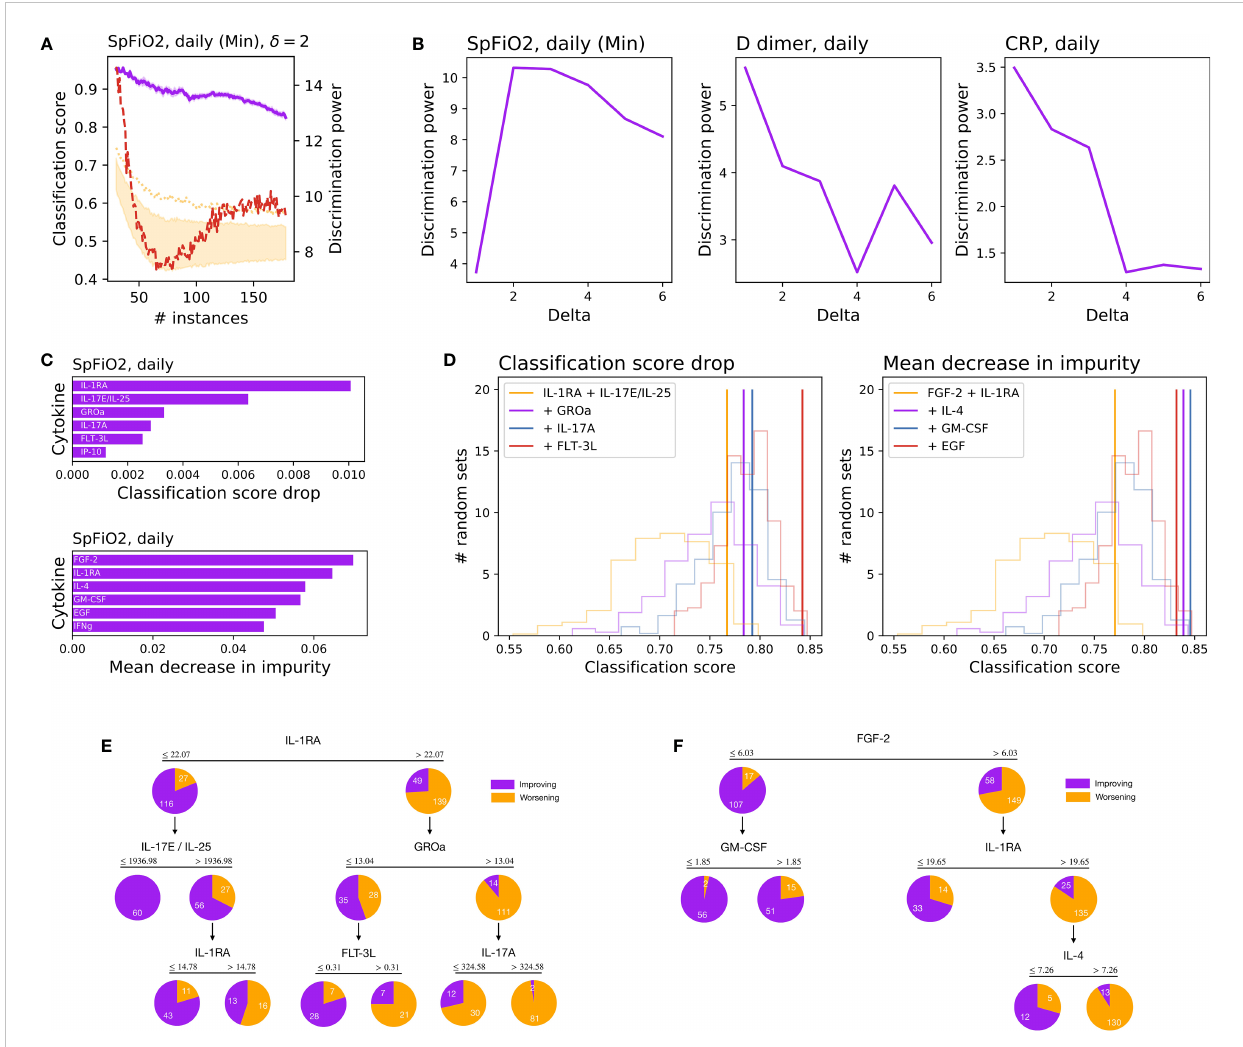
FIGURE 4 Results of the machine learning analysis and models. (A) Classi fi cation score (purple line, left Y axis) between two equal-sized groups of most improving and most deteriorating patients, as a function of the number of patients in each group, for a delay of d =2 days. The orange band and dotted line respectively represent the 10-90 percentile and 99 percentiles of a random classi fi cation. The red line (right Y axis) depicts the variations of the discrimination power. (B) Variations of the discrimination power, as a function of the number of days, for the three metrics used to assess the status of the patient. (C) Ranking of the fi ve most important cytokines for forecasting the status of patients two days ahead, according to the classi fi cation score drop (top) and mean decrease in impurity (bottom). (D) Classi fi cation score obtained by a RF model, using an increased set of cytokines – as ranked in the previous step. Transparent curves represent the probability distributions of the classi fi cation score, when models are trained with a random set of features. (E) Decision tree for to the fi ve features selected using the classi fi cation score drop criterium. (F) Decision tree for the four features selected using the mean decrease in impurity